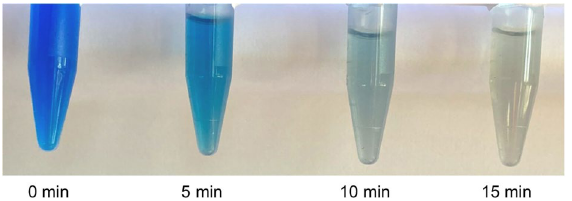
Figure 8. Photos showing the degradation of the methylene blue dye solution treated by the plasma jet every five minutes. The plasma jet parameters were f = 21kHz , V d = 10.2kV and gas flow rate Q Ar = 6 sL/min